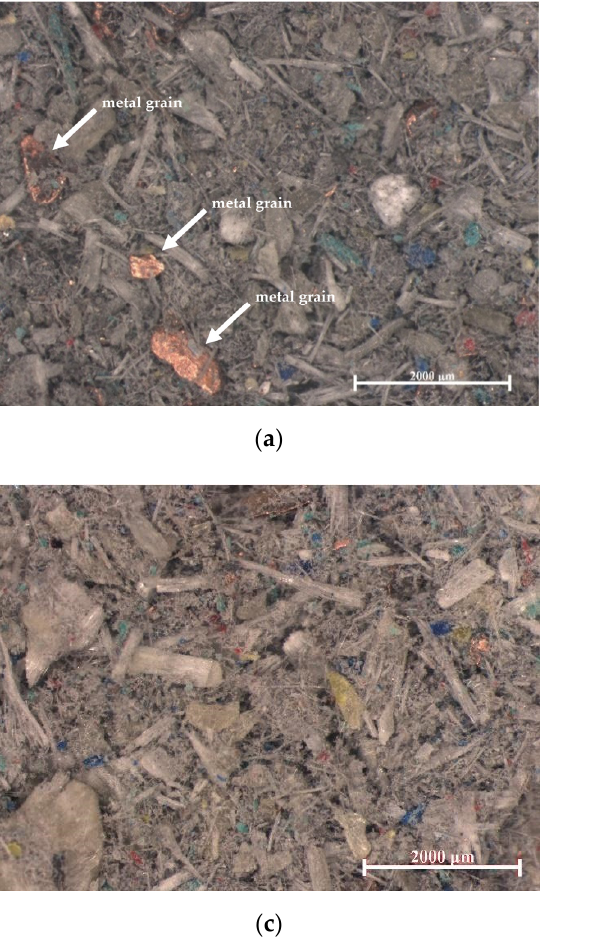
Figure 2. Waste from electrostatic separation (stereo microscope): ( a ) option 1, ( b ) option 2, ( c ) option 3, ( d ) and option 4. Table 1. Yield of grinding product grain classes.